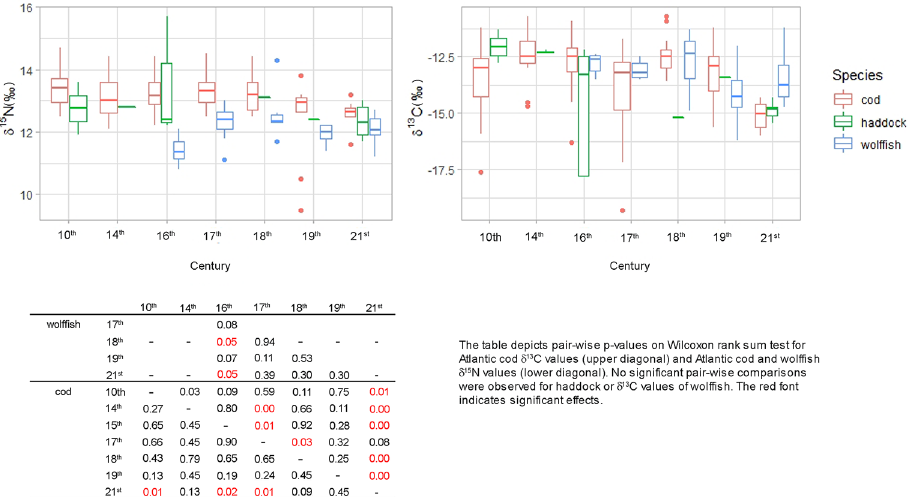
Figure 2. δ 13 C and δ 15 N values from all of the samples used dated from 970 CE and until present-day. The box plots show the stable isotope values in each of the temporal groups, specifically, the median (horizontal line), first (box) and third (whiskers) quartile. Values falling out with the third quartile are presented as